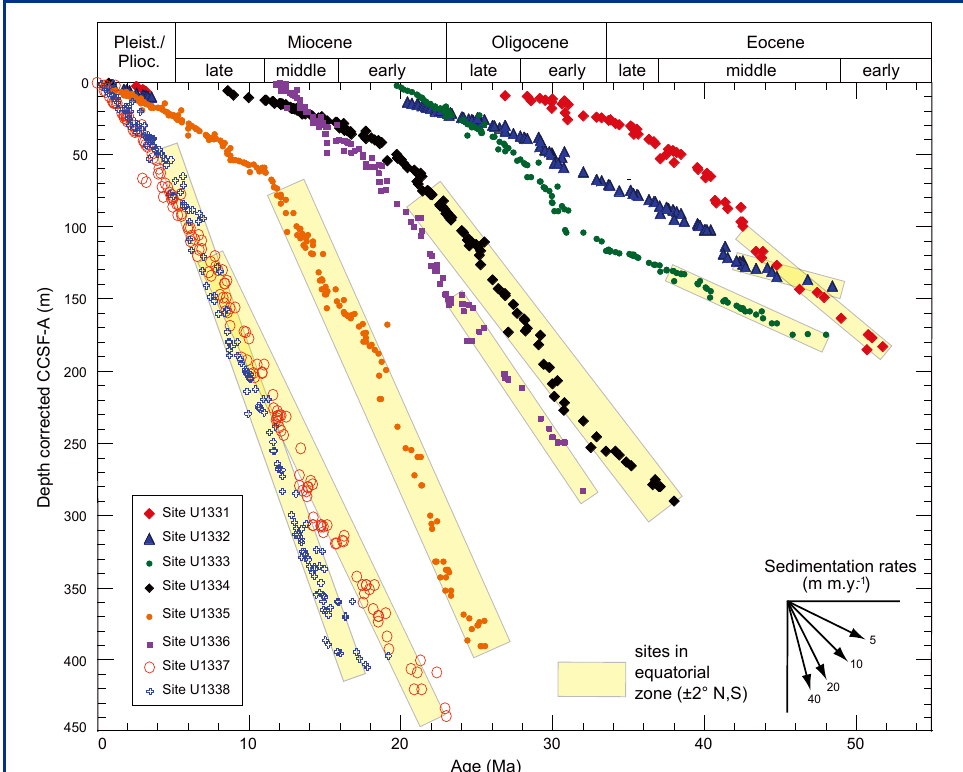
Figure 5. Summary of chronostratigraphic datum levels identified at PEAT sites plotted versus corrected composite depth (spliced depth compacted back to depth measured by the drill string). A steeper slope corresponds to a higher sedimentation rate. Yellow boxes mark approximate times when each drill site was within the equatorial zone (±2° N or S of the equator) based on estimated absolute motion of the Pacific tectonic